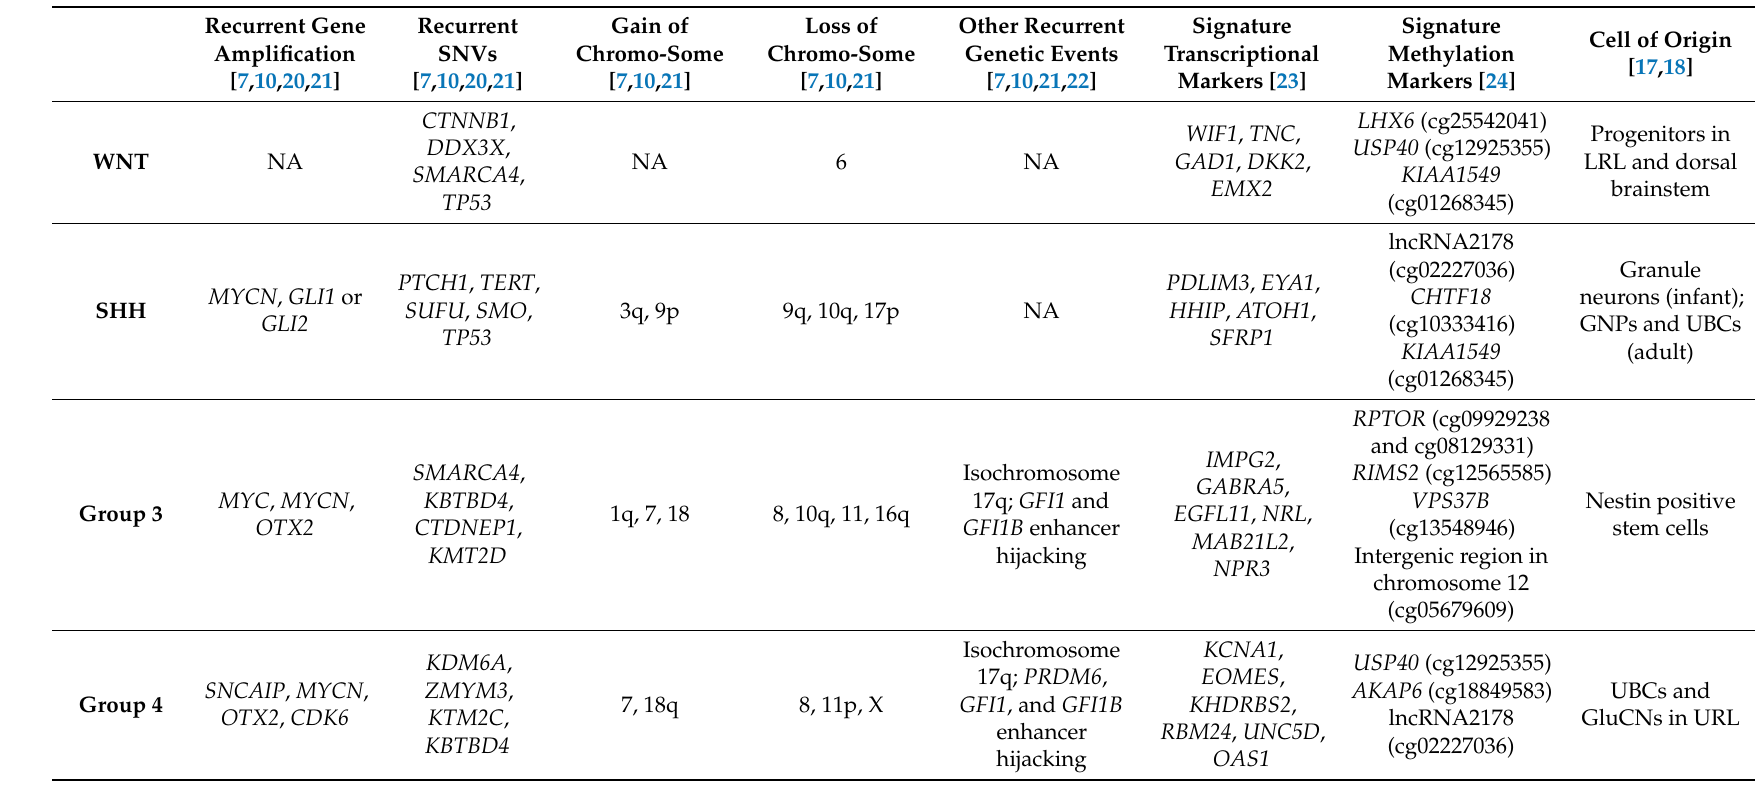
Table 1. Summary of cellular, genetic and molecular and characteristics in MB